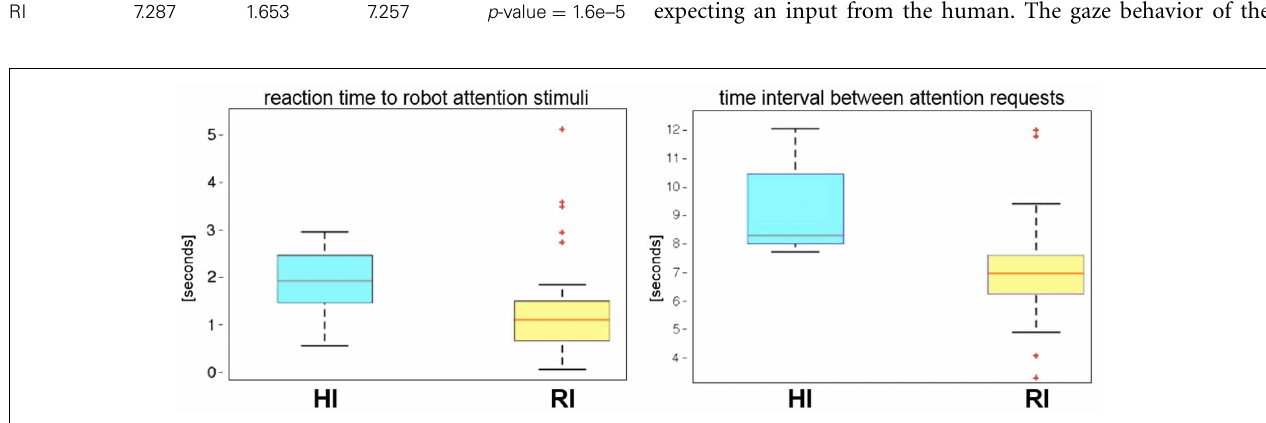
FIGURE 7 | Reaction time to robot attention stimuli and time interval between consecutive attention requests in the verification